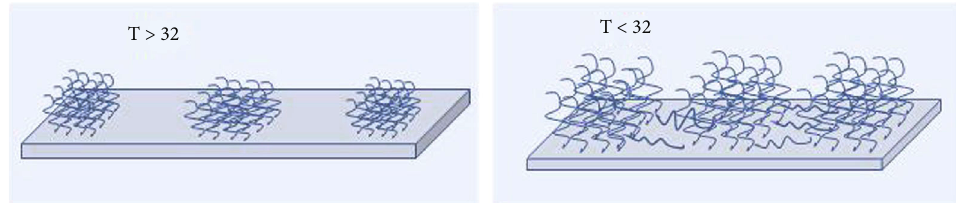
Figure 3: Schematic of the PNIPAM polymer brush structure in a solvent above the LCST and below the LCST [21]. Beam expander with pinhole in between the two lenses Half wave Laser plate source